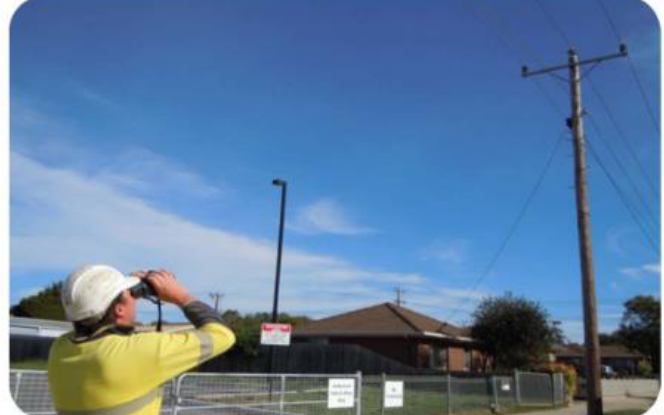
Figure 3. Visual inspection technique carried out from ground